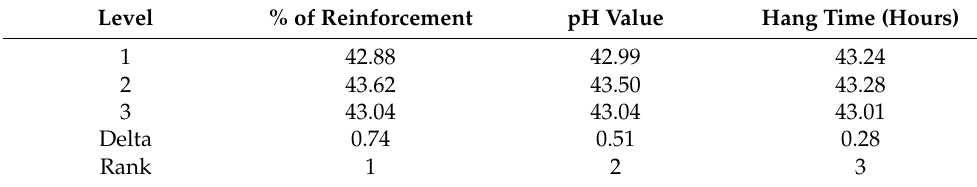
Table 20. Response table for signal to noise ratios (microhardness test). Larger is better.